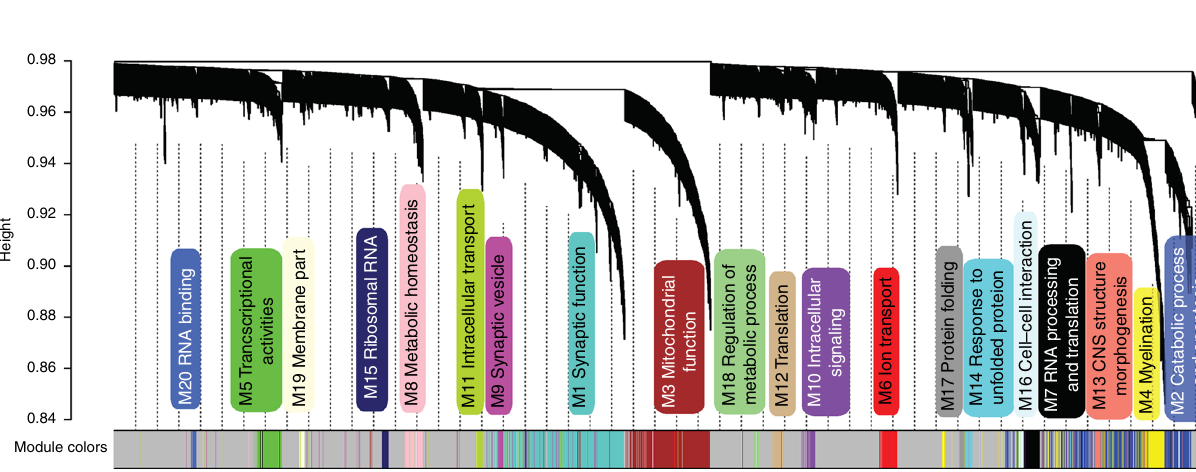
Fig. 4 Protein co-expression network. This fi gure shows the WGCNA cluster dendogram and 20 distinct protein co-expressed modules de fi ned by dendogram branch cutting in the Banner cohort. Each module is given in a box with the module number and a functional summary of the proteins in the module derived by gene ontology enrichment. The underlying data are provided as a Supplementary Data 7